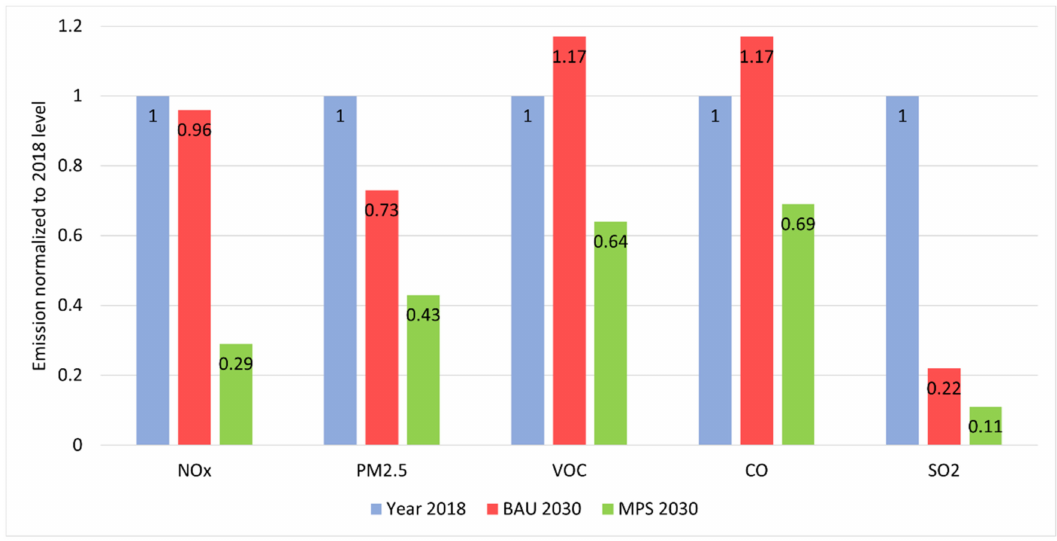
Figure 7. Combined relative emission levels for Haifa and Ashdod for the year 2018, BAU 2030 and MPS 2030 scenarios. Y axis is the emission level of the pollutants, relative to 2018 levels. Shown are emissions for NOx, PM 2.5 , VOC, CO and SO 2 . Blue: the baseline level of annual 2018 calculated emissions; red: the level of yearly emissions in BAU (business as usual) for the year 2030 scenario; green: the level of yearly emissions in MPS (Mitigation Plan Scenario) for the year 2030. See absolute numbers in Appendix